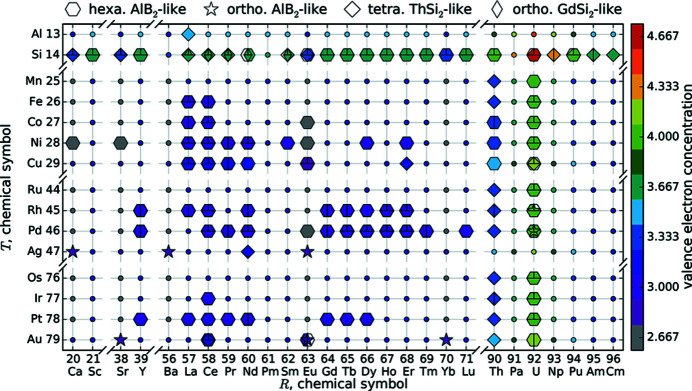

R–T diagram for the valence electron concentration vec of the RSi2 and R
2
TSi3 compounds. The used markers symbolize the crystal system: hexagon — hexagonal AlB2-like systems, open star — orthorhombic, AlB2-like systems, diamond — tetragonal ThSi2 systems, elongated diamond — orthorhombic GdSi2 systems.